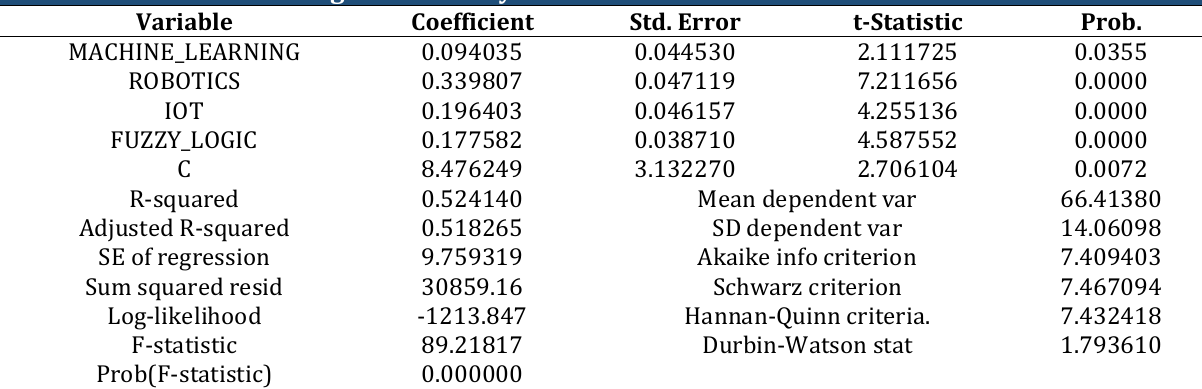
Table 22: Results of the regression analysis